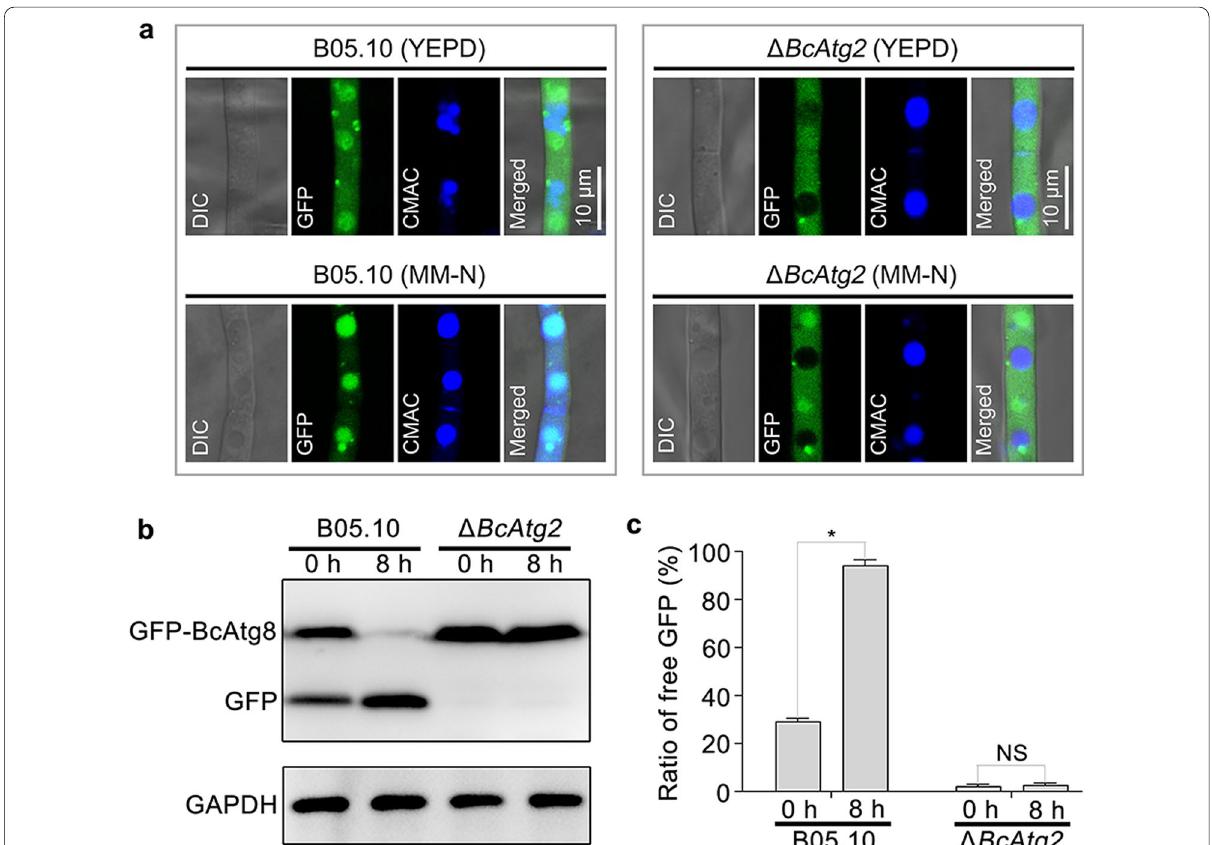
Fig. 3 BcAtg2 is essential for autophagy in B. cinerea . a Subcellular localization of GFP-BcAtg8 in the wild-type strain B05.10 and the BcATG2 deletion mutant Δ BcAtg2 with or without nitrogen-starvation treatment. Vacuoles were stained with CMAC (7-amino-4-chloromethylcoumarin). b Analysis of proteolysis of GFP-BcAtg8 in the wild-type strain B05.10 and Δ BcAtg2 with or without nitrogen-starvation treatment using anti-GFP Western blot. GAPDH was used as an internal reference. c The percentage of free to total GFP. Error bars denote standard deviations from three independent experiments, and asterisks indicate statistically significant differences at P 0.05, NS indicates no significant =